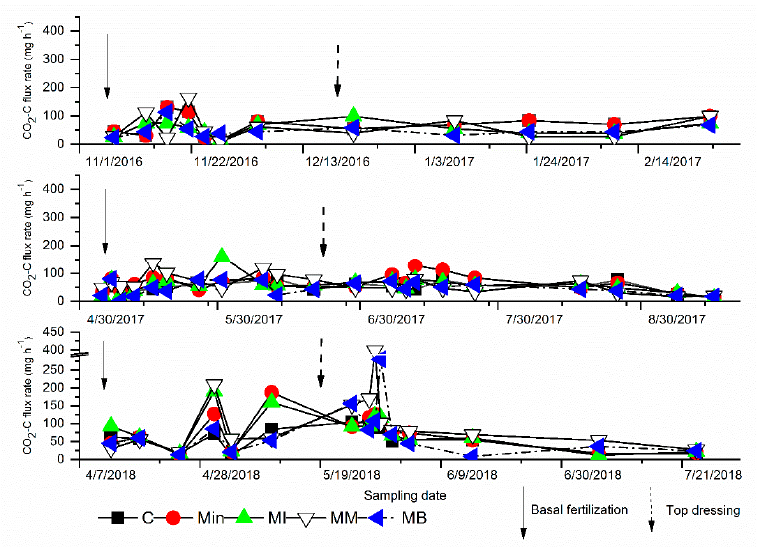
Figure 6. CO 2 (CO 2 − C mg ha − 1 h − 1 ) flux rates from maize plots with different nitrogen (N) fertilizer treatments and a no N control (C) over three crop growing seasons. Continuous line arrows indicate basal fertilizer application while dashed line arrows indicate top dressing .